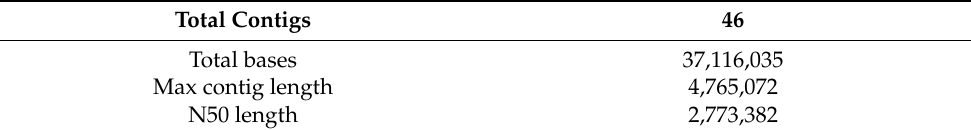
Table 2. Epichloë festucae Rose City isolate long-read genome assemble.